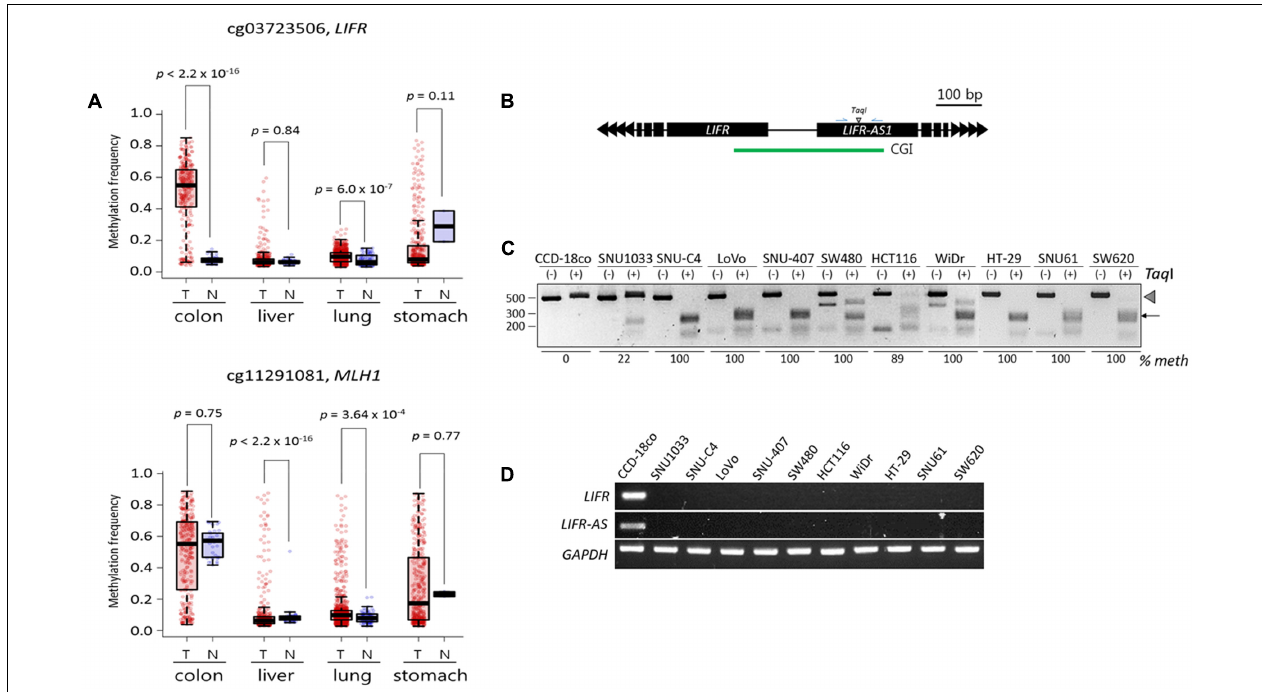
FIGURE 5 | Validation of the LIFR promoter methylation for cancer specificity and its relationship with the expression of associated genes. (A) DNA methylation levels of target CpGs in public cancer methylome data (Infinium 450K BeadChip array) of four cancer types: colorectal ( n = 313 for cancer samples and n = 38 for normal samples), liver (377 and 50), lung (843 and 74), and stomach (395 and 2) cancers. Infinium CpG identification numbers (IDs) together with the associated gene names are shown; the Infinium IDs cg03723506 and cg11291081 indicate chr5:38557143 and chr3:37033894, respectively, in the Figure 3B .